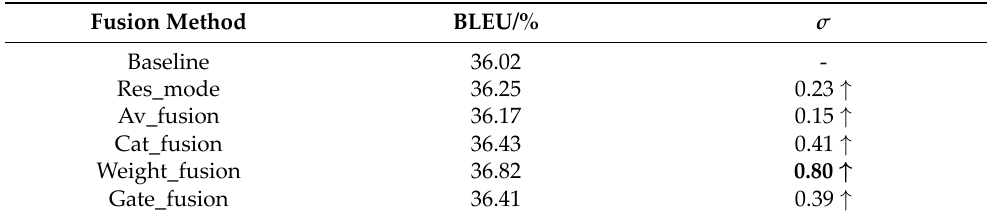
Table 1. BLEU value of vector fusion experiment.